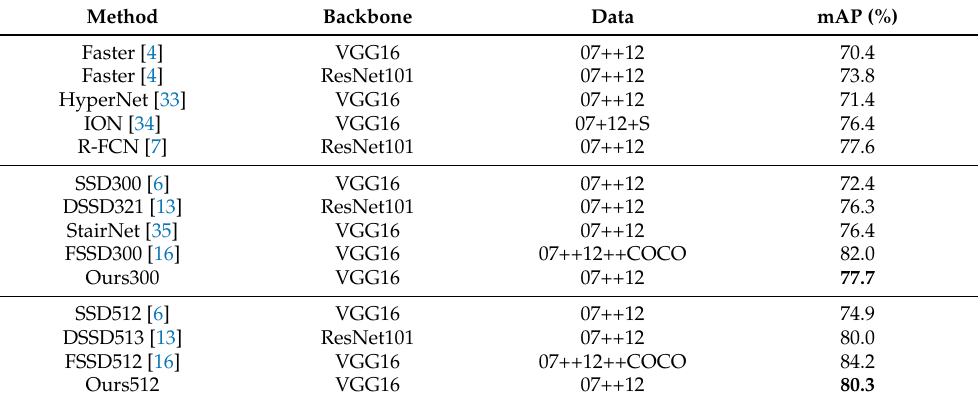
Table 3. PASCAL VOC 2012 test results from official evaluation server. For training data: “07+12”: union of VOC2007 trainval and VOC2012 trainval ; “07++12”: union of VOC2007 trainval and test